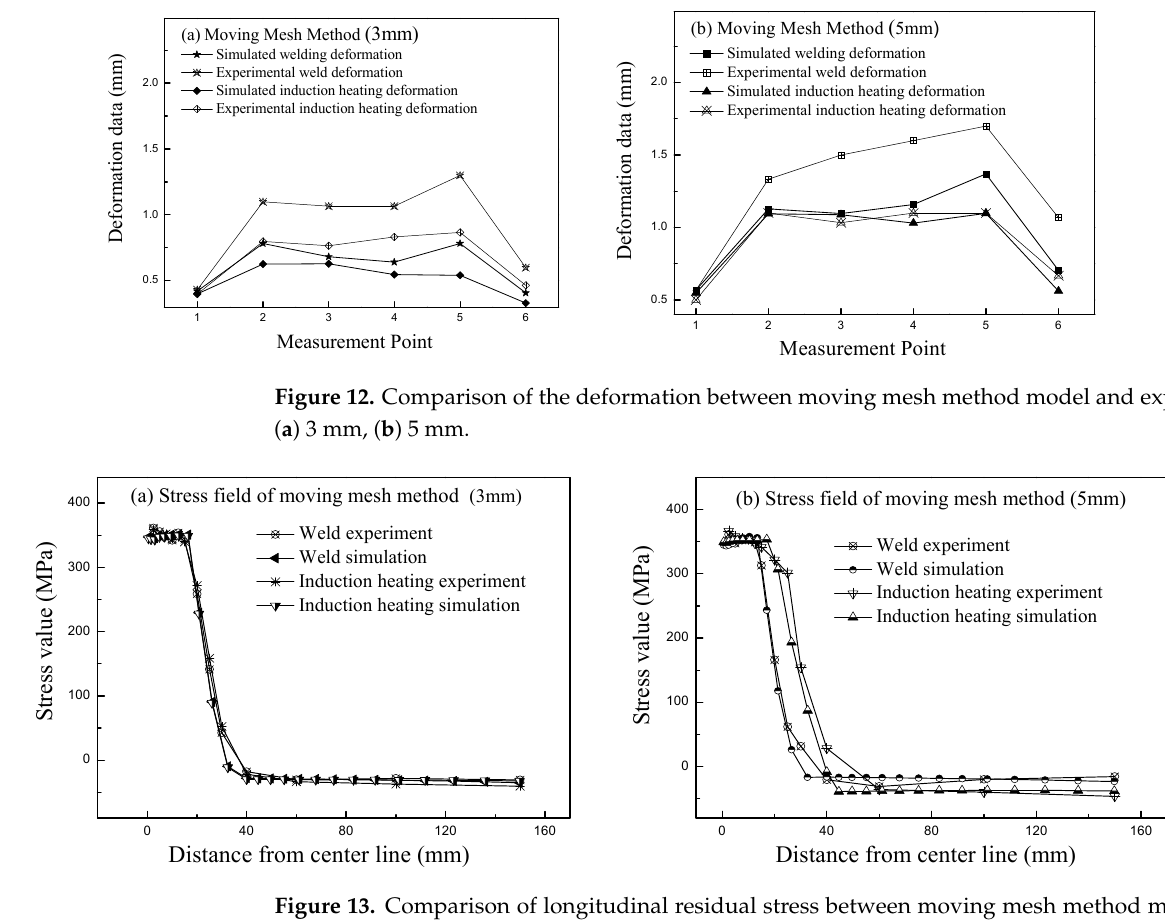
Figure 13. Comparison of longitudinal residual stress between moving mesh method model and experiment. 3 mm thickness (Plate No. 3) and 5 mm thickness (Plate No. 6). ( a ) 3 mm, ( b ) 5 mm.